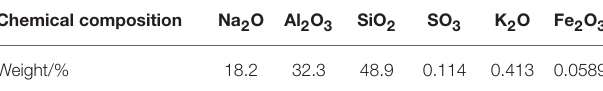
TABLE 2 | XRF analysis of zeolite X